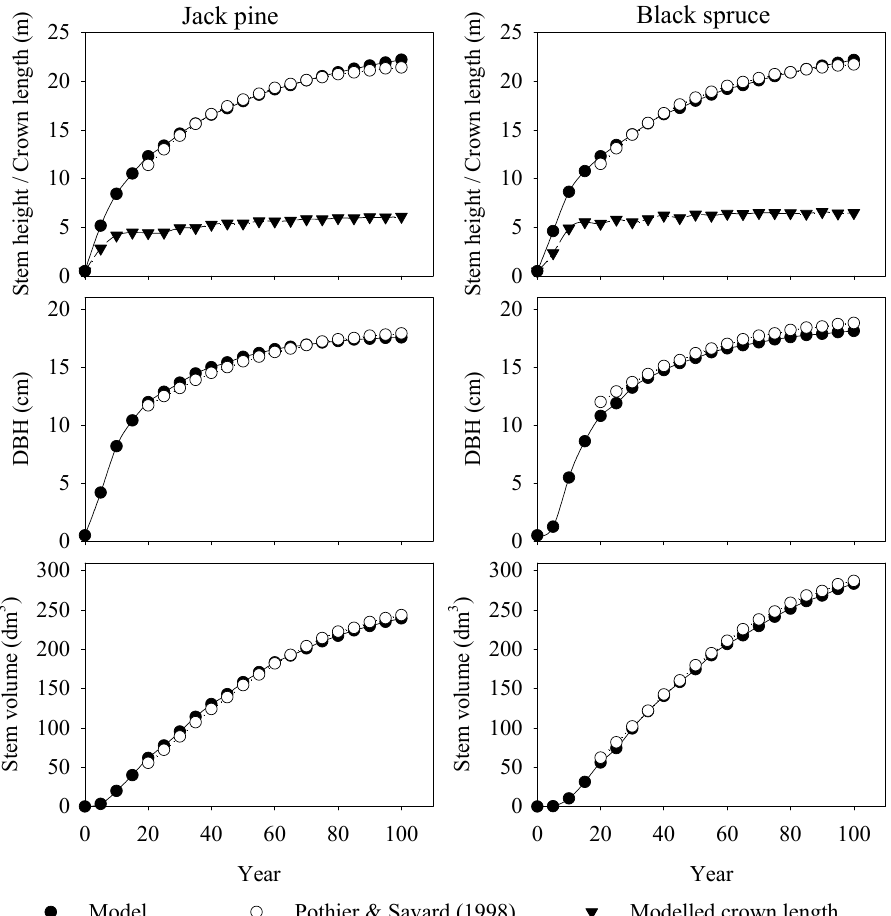
Figure 1. Jack pine and black spruce modeled tree height, diameter at 1.30 m, and volume contrasted with data of growth and yield tables [38] derived from stands with Site Index = 18 m at 50 years, and stand density at age 20 of 1.191 tree ha − 1 for jack pine and 1.225 trees ha − 1 for black spruce.